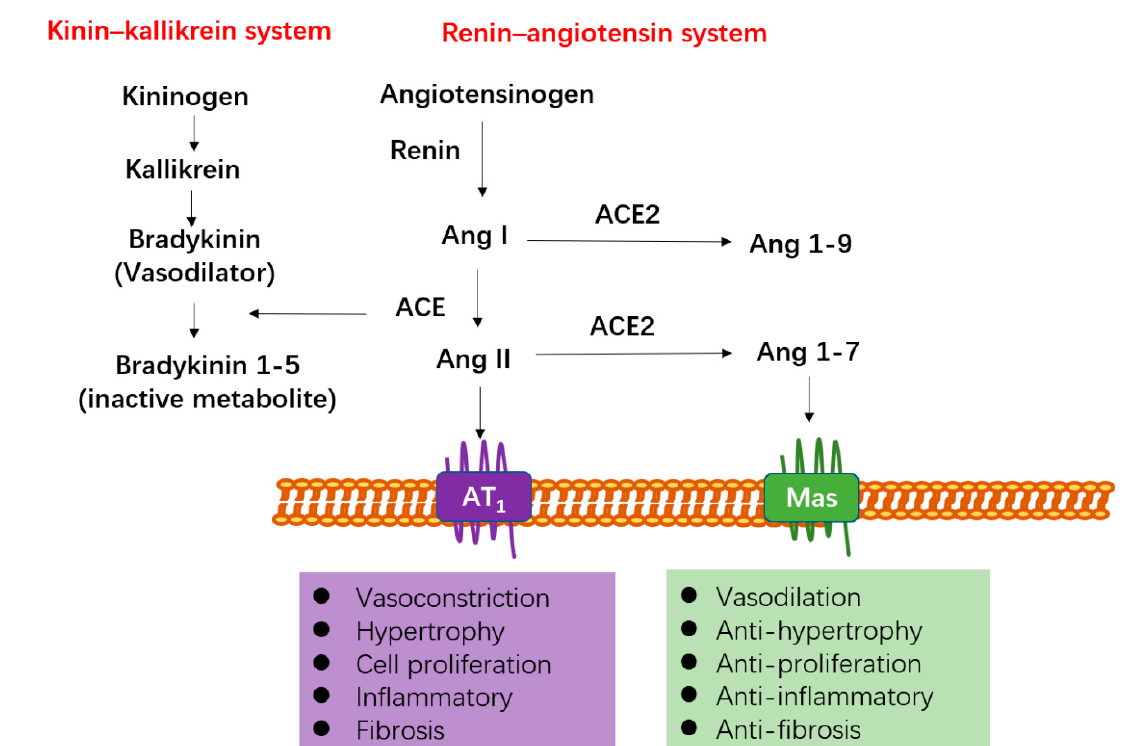
Figure 1. The regulatory mechanism of ACE and ACE2. ACE and ACE2 are both type I membrane- anchored zinc dipeptidyl carboxypeptidase responsible for the cleavage of multiple substrates, including vasoactive peptides. ACE and ACE2 could be considered to act as counterbalances in RAS. ACE participates in the production of the vasoconstrictor Ang II, exerting its effects by binding to G-protein coupled receptor named AT1. ACE2 engages in the conversion of Ang II to Ang 1–7 and Ang I to Ang 1–9, which is much lower efficiency than conversion to Ang 1–7. Ang 1–7 binds to the Mas receptor and a seven transmembrane G-protein-coupled receptor. Ang 1–7 produces vasodilation, anti-hypertensive, anti-proliferation, anti-inflammatory, and anti-fibrotic effects, which is opposed to the actions mediated by Ang II. ACE also exerts important effect on the kinin–kallikrein cascade. ACE converts the strong vasodilator bradykinin, to bradykinin 1–5, which is an inactive metabolite. Thus, ACE is a prominent regulator in blood pressure through RAS and kinin–kallikrein as well.